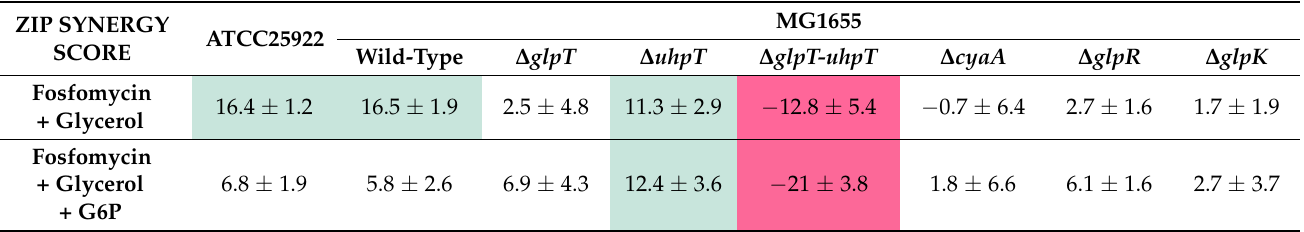
Table 2. ZIP synergy scores for the combination of fosfomycin with glycerol, with and without glucose- 6-phosphate (G6P). Green and red colors show synergistic and antagonistic results, respectively.